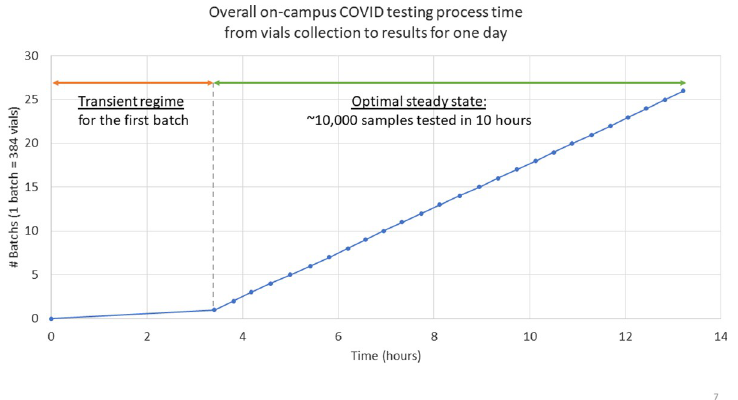
Fig 7. Testing time of vials batches in transient and continuous